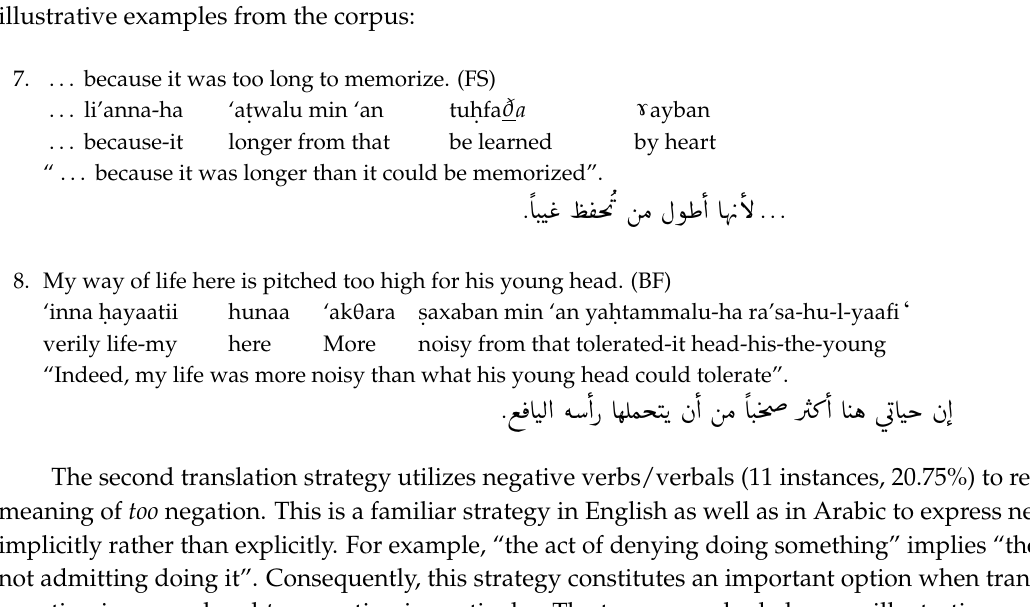
Table 4. Frequency and percentage of translation strategies in rendering -ly